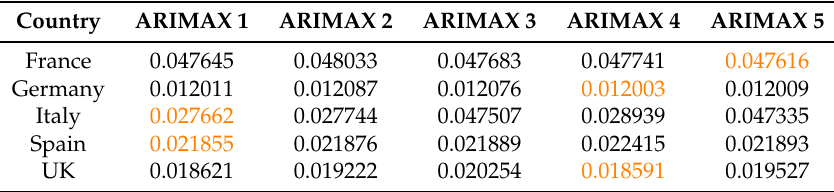
Table 14. RMSE for out-of-sample period of ARIMAX models for mean country